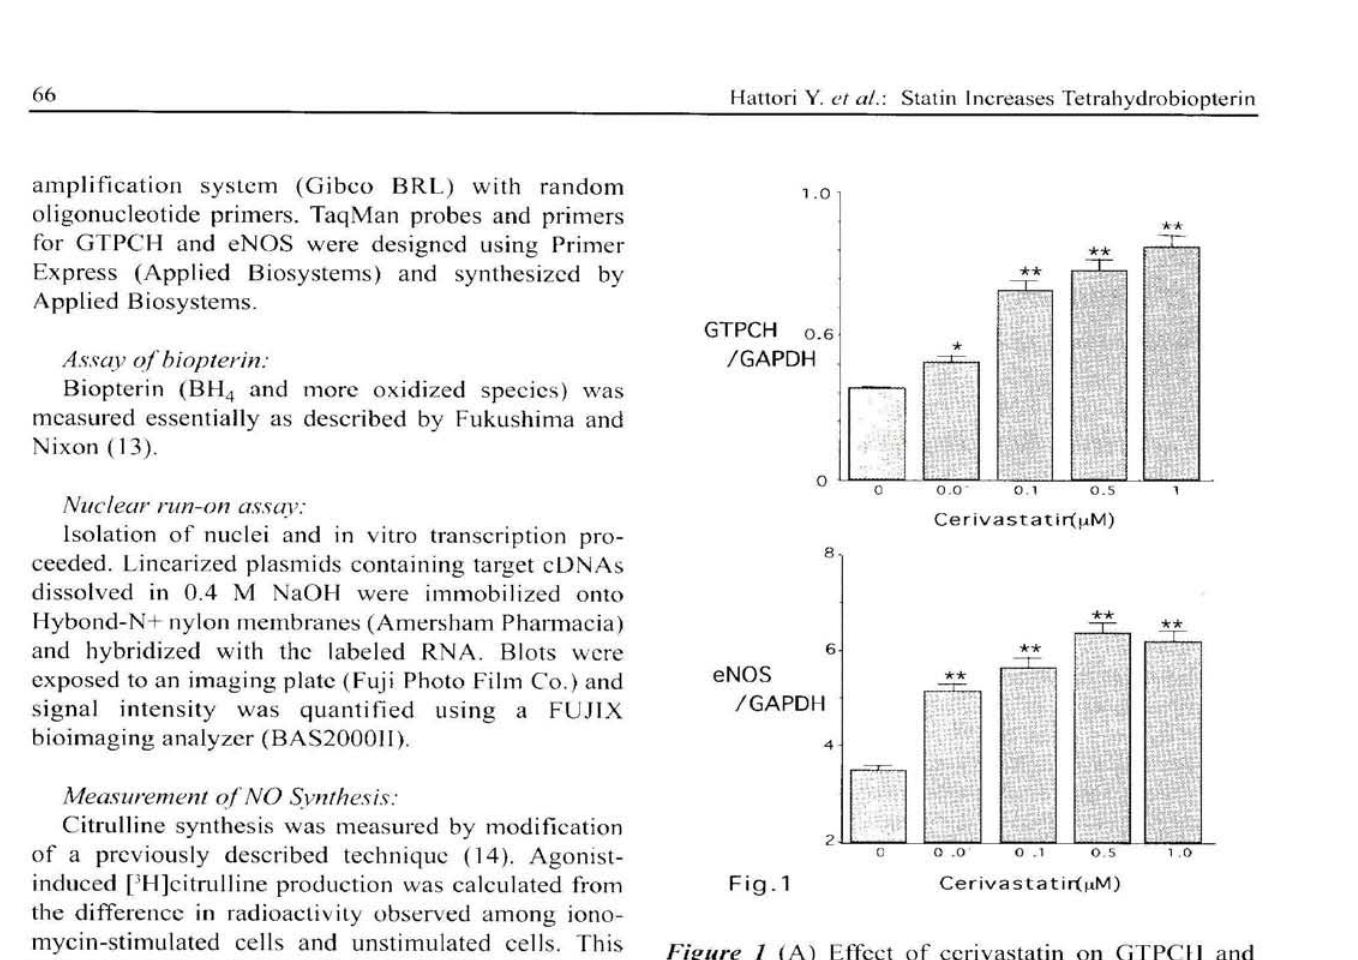
Figure 1 (A) Effect of cerivastatin on GTPCH and eNOS mRNA levels in HUVEC. Cells were incubated with cerivastatin (0.01 - 1 μΜ) for 24 h, after which mRNAs for GTPCH and eNOS were measured by Realtime PCR. Insert: Time course of mRNA levels following incubation with cerivastatin (0.5 μΜ). Data represent the mean ± SEM (n=3). *P <0.05 and **P <0.01 compared with control. mRNA levels. Fluvastatin also increased the mRNA levels of both GTPCH and eNOS (data not shown).